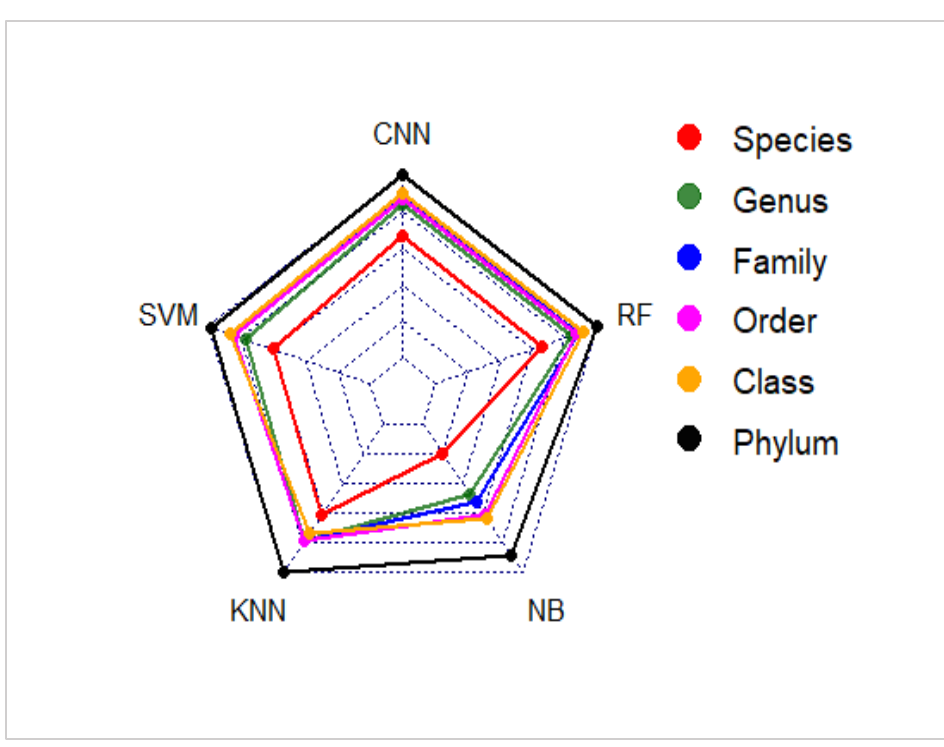
Figure 7. Average accuracies (%) obtained by CNN, SVM, KNN, Naïve-Bayes and Random Forest classifiers with 6-mer features at various taxonomic levels.